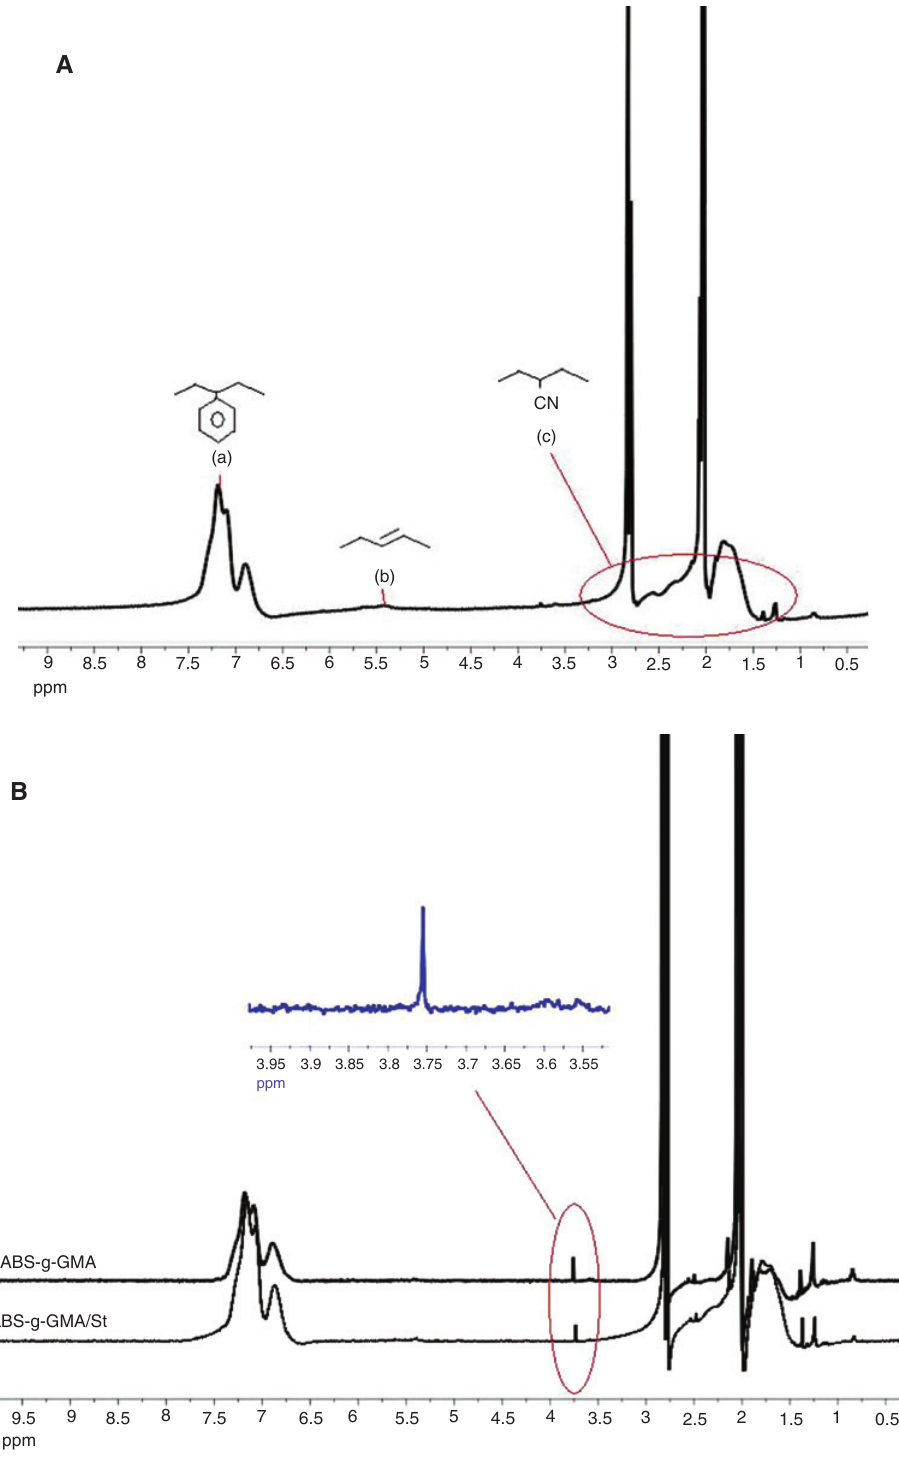
Figure 2 1 H NMR spectra of pure ABS (A) and ABS-g-GMA, ABS-g-GMA/St (B). St acts as a reactive linker between the modifier and the polymer, enhancing the free radical grafting efficiency of GMA on polymers. The curves in Figure 6 have a similar trend with those in Figure 5, which indicates that the